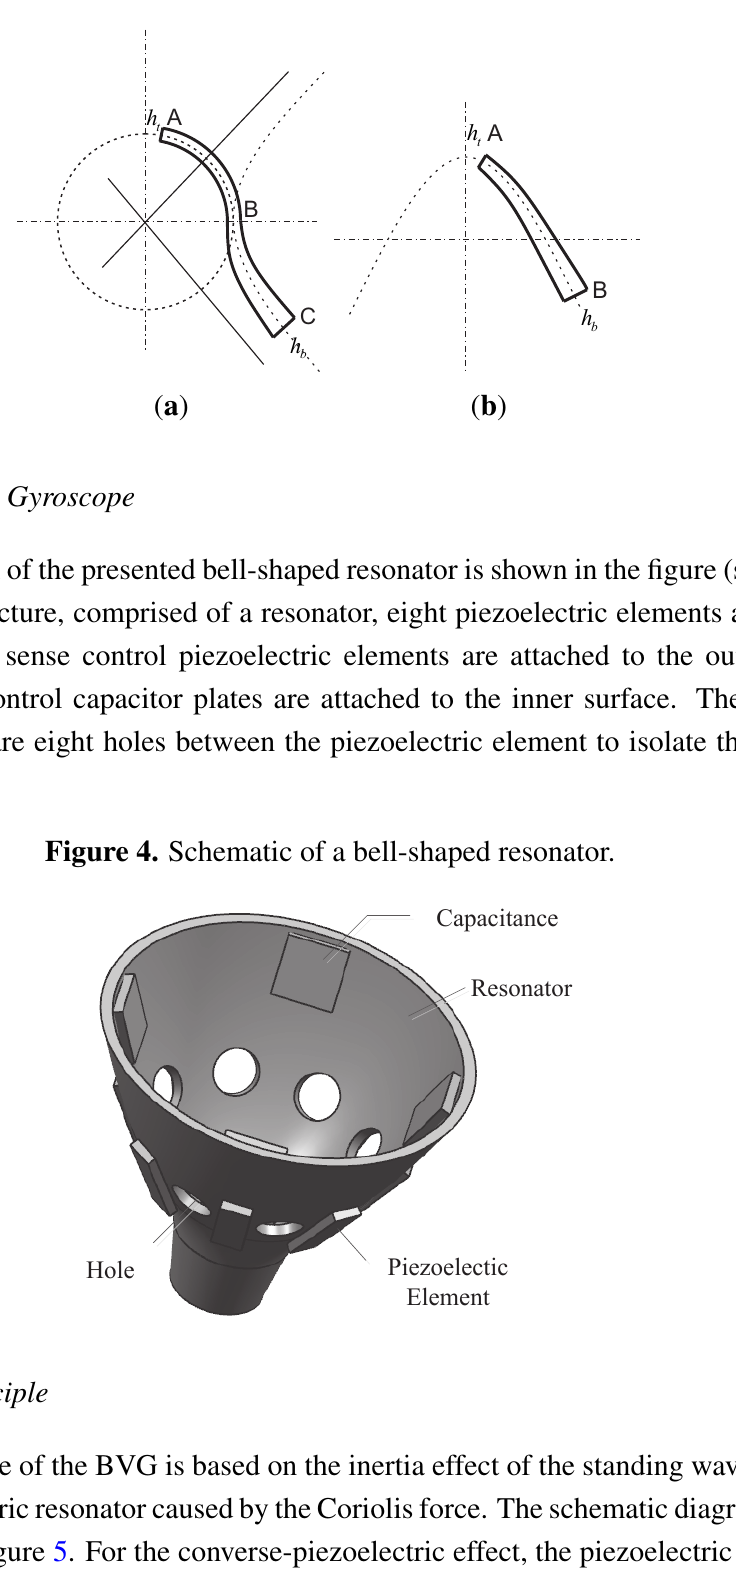
Figure 3. Cross-section of a bell-shaped resonator with a variable thickness axisymmetric multi-curve.